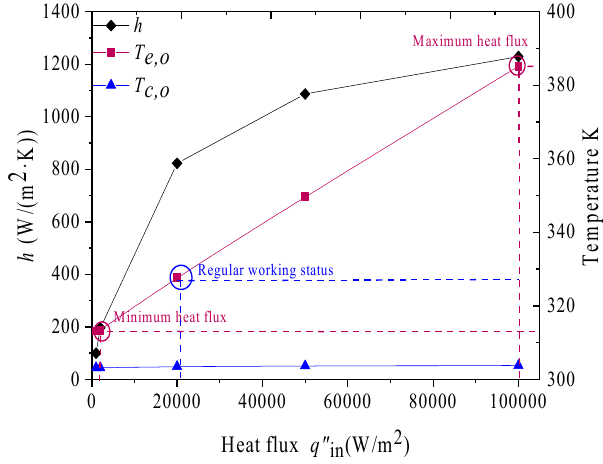
Figure 3. Heat transfer performance under different input heat flux.